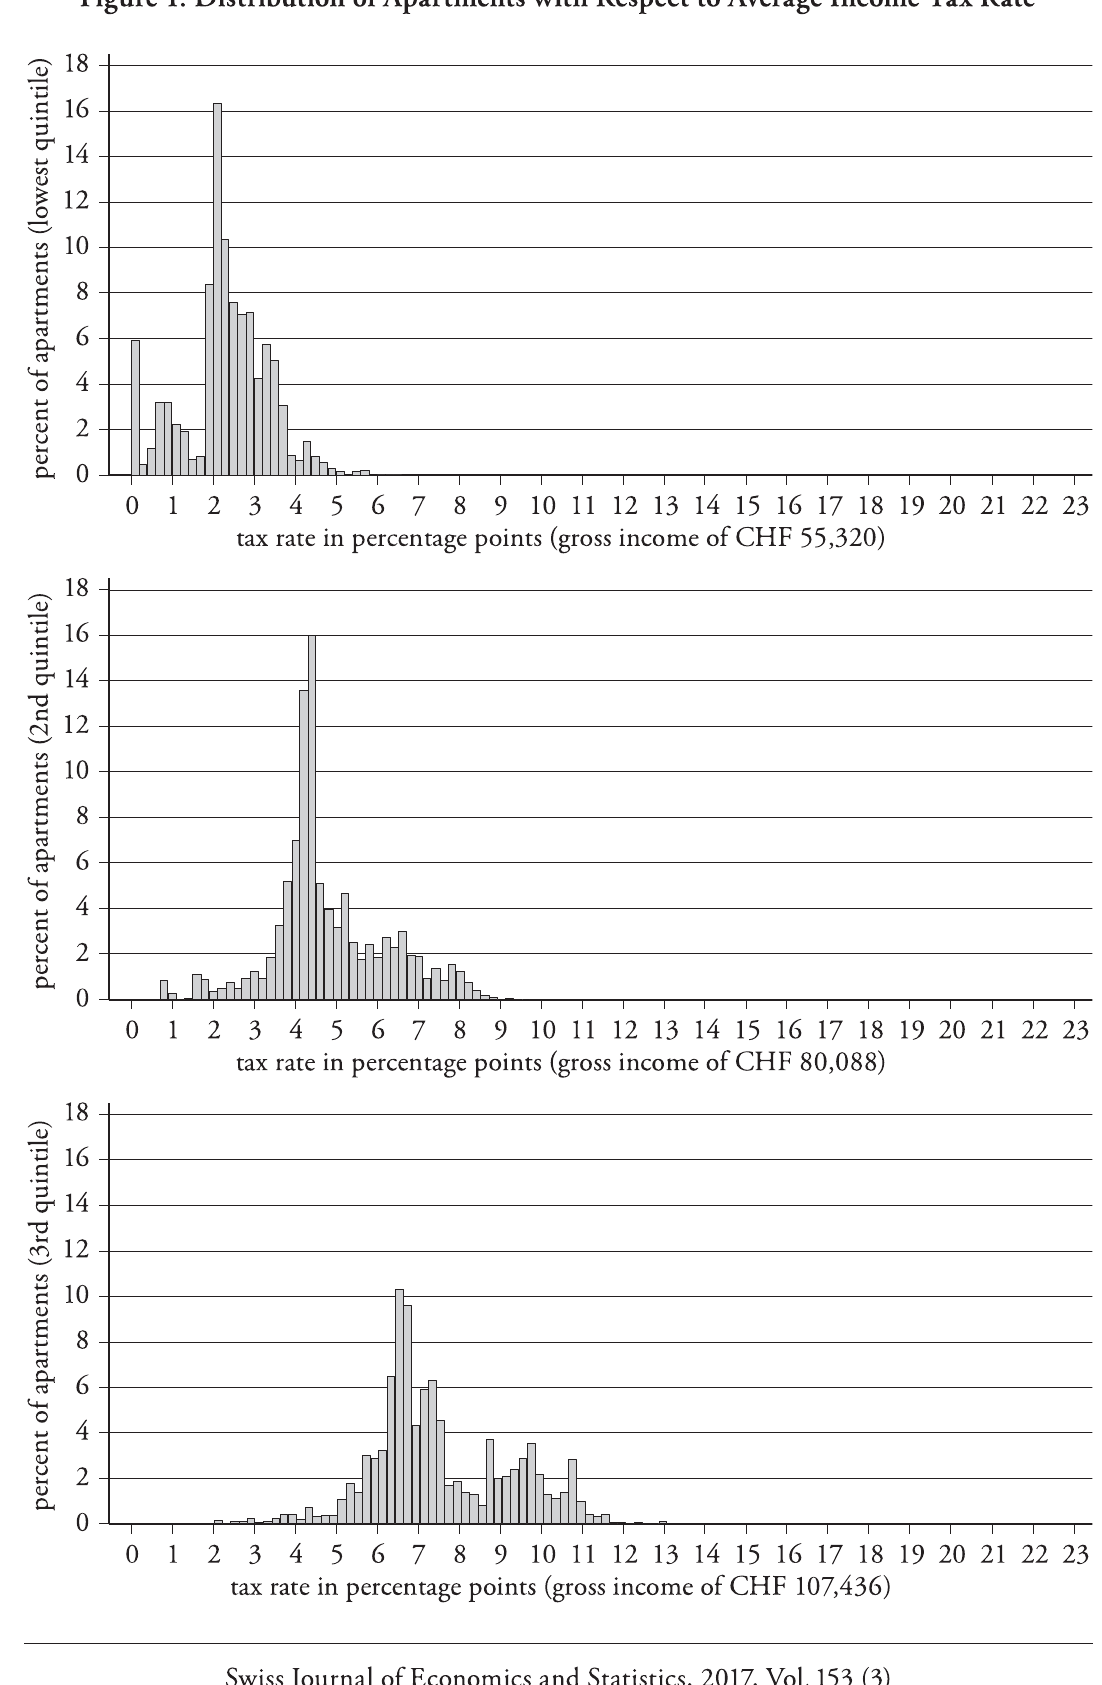
Figure 1: Distribution of Apartments with Respect to Average Income Tax